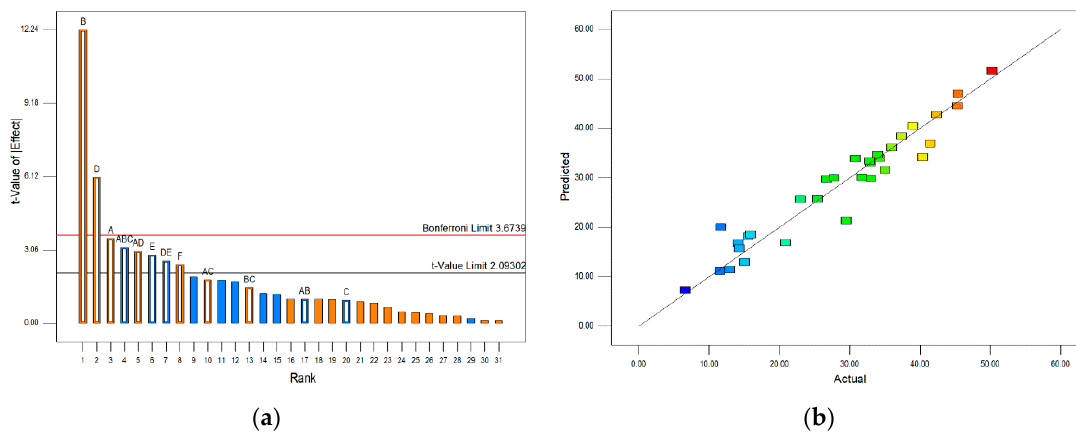
Figure 2. Caftaric acid content model: ( a ) Pareto chart; ( b ) actual vs. predicted results. Independent variables: A = glycerol concentration; B = temperature; C = ultrasound power; D = time; E = ascorbic acid concentration; F = amount of solvent. Blue color on the chart ( a ) indicates a negative and the orange color refers to a positive effect of independent variables. The color points on the chart ( b ) represent the value of caftaric acid (blue: lowest value; red: highest value).